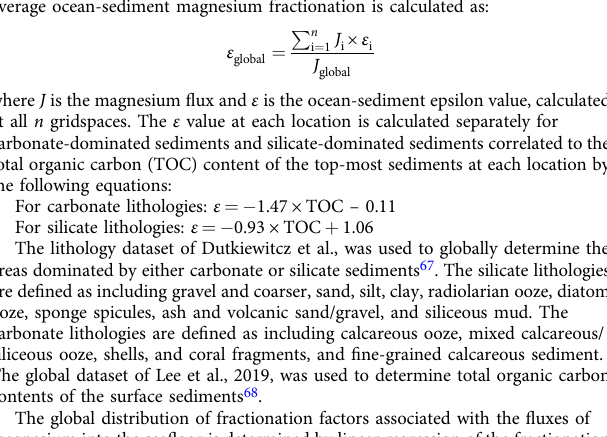
relative to DSM3 standard 61 . Repeated analyses indicate data reproducibility is ± 0.06 ‰ (2 σ ) or better for δ 26 Mg, far below the natural variations observed in the pore water pro fi les. Hydrothermal fl uids from IODP Site 1253 CORK observatory samples were measured using the same procedures as the pore water samples 62 . All measured magnesium isotope analytical data are provided in the Supplementary Table 4. Additional pore water magnesium isotope values from ODP Sites 925, 984, 1012, 1082, 1086, 1171, and 1219, and IODP Sites U1378 and U1395 were obtained from published sources 24,34,63 . Other sites with available pore water magnesium isotope data are excluded that are either sparse near the sediment-water interface, affected by brine diffusion, or associated with unquanti fi ed pore water advection in relationship δ 25 Mg = 0.516× δ 26 Mg for sites 925, 984, 1012, 1082, 1086, and 1219, for which δ 25 Mg values are not published 65,66 .